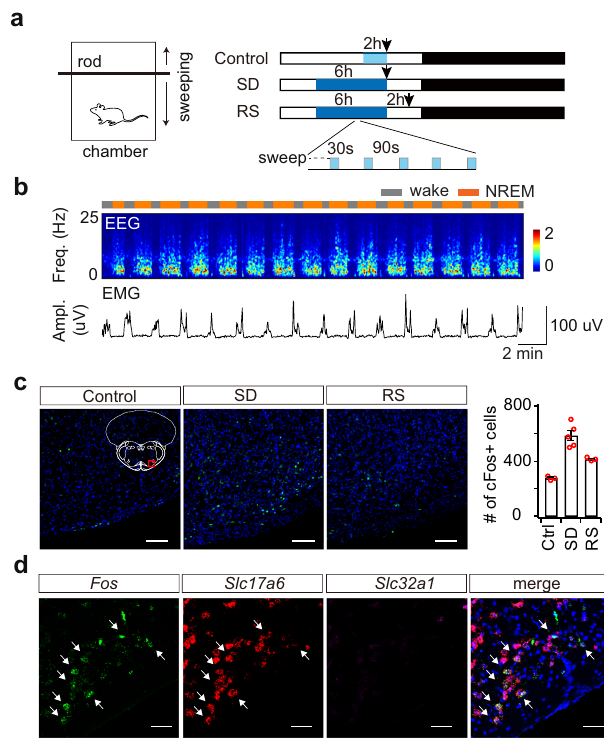
Fig. 1 | Medulla glutamatergic neurons are active during wake – sleep transi- tions.a Schematicofsleepdeprivation.Animalsweredividedinto three groups:1) control, 2-h sweeping before perfusion, 2) sleep deprivation (SD) by 6-h inter- mittent sweeping (30s on, 90s off), 3) recovery sleep (RS) after deprivation. Arrows indicate perfusion time. b Representative EEG spectrogram and EMG trace showing 30-min sleep pattern at the 5th hour of sleep deprivation. Brain states: gray, wake; orange, NREM sleep. c Fluorescence images of c-Fos immunostaining (green)inthe VLMofthree groups:control,SD,and RS.Blue,DAPI. Scalebars, 100 μ m. Inset, mouse brain coronal section (Bregma − 6.9mm), adapted from Allen mouse brain atlas (http://atlas.brain-map.org). Red box indicated the region of fl uorescence images. Right, Quantitation of c-Fos+ cells in the VLM in each group ( n =3miceforcontrol, n =5forSD, n =3forRS).Dataarepresentedasmean±SEM. Source data are provided as a Source Data fi le. d Triple fl uorescence in situ hybridization (FISH) of Fos and neuronal markers in the VLM of a SD mouse ( n =2 mice). Slc17a6 , vesicular glutamate transporter 2; Slc32a1 , vesicular GABA trans- porter.Arrows indicated the overlapped cellsbetween Fos and Slc17a6 . Blue, DAPI. Scale bars, 50 μ